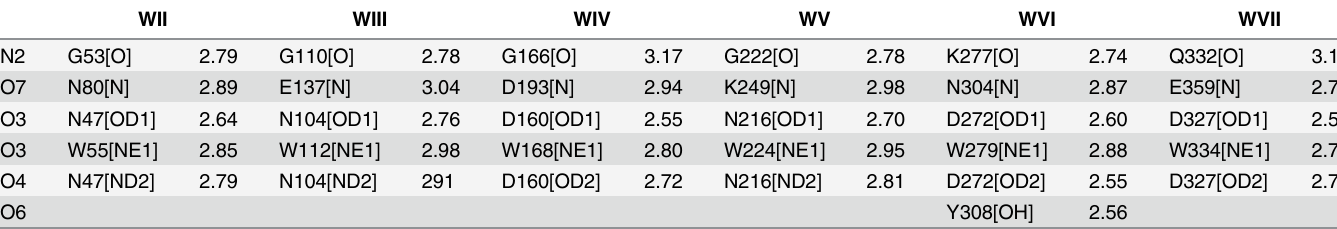
Table 2. Polar interactions (distances in Å ) between atoms from GlcNAc (left column) and AAL2. WII WIII